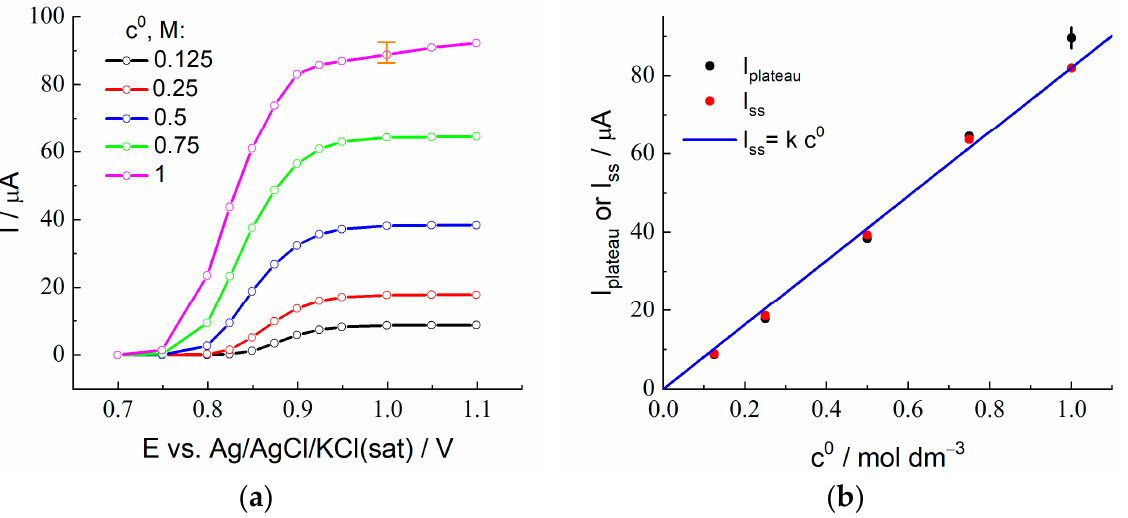
Figure 2. ( a ) Results of the stationary voltammetry for the platinum electrode (diameter: 1 mm) coated with Nafion 212 membrane in contact with 2 M sulfuric acid solution with the addition of HBr, c 0 from 0.125 to 1.0 M (its values are indicated in the figure). ( b ) Dependence of the steady-state diffusion-limited current found as the plateau current of the stationary voltammograms, I plateau (black), in ( a ), or as the stationary current on chronoamperograms, I ss (red), in Section Chronoamperometry: X − Oxidation Stage, on the HBr concentration in solution. The straight line (blue) given by the equation: I ss = k c 0 , illustrates the proportionality of the stationary current, I ss , to the HBr concentration in solution.